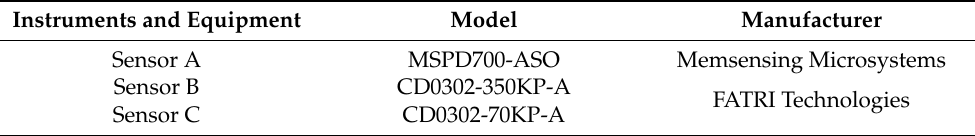
Table 2. Models and manufacturers of the instruments and equipment.